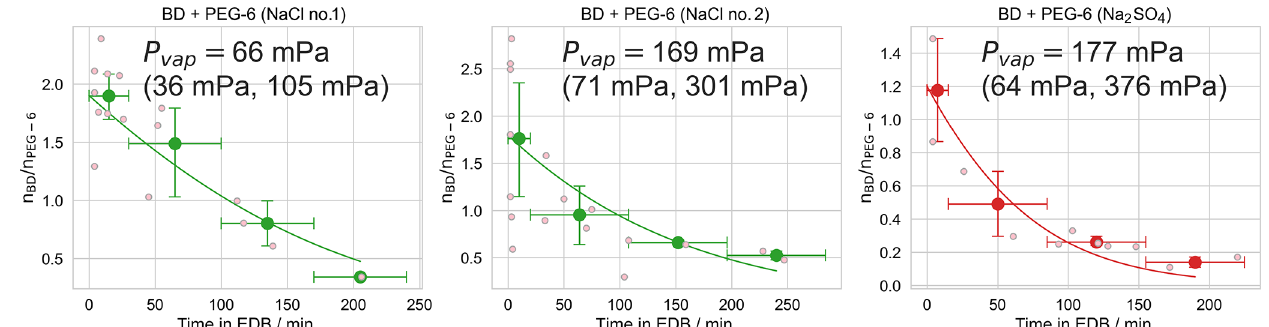
Figure 7. Experiments used to determine the effective vapor pressure of butenedial (BD) in a droplet also containing hexaethylene glycol (PEG-6) and either sodium chloride (NaCl) or sodium sulfate (Na 2 SO 4 ), under humid (RH 75 ± 5%) conditions. Small pink points are observations of individual droplets and the line is the best model fit, as described in the text. Large points are the mean binned values from the bootstrapping procedure, with x -axis error bars showing the width of the bins and y -axis error bars representing a 95% confidence interval of the mean value in the bin, over all bootstrapped realizations. The plotted model fit is for the mean vapor pressure obtained by averaging over all model fits to all realizations. The vapor pressure is reported as a 95% confidence interval over repeating the fitting procedure over 10000 bootstrapped